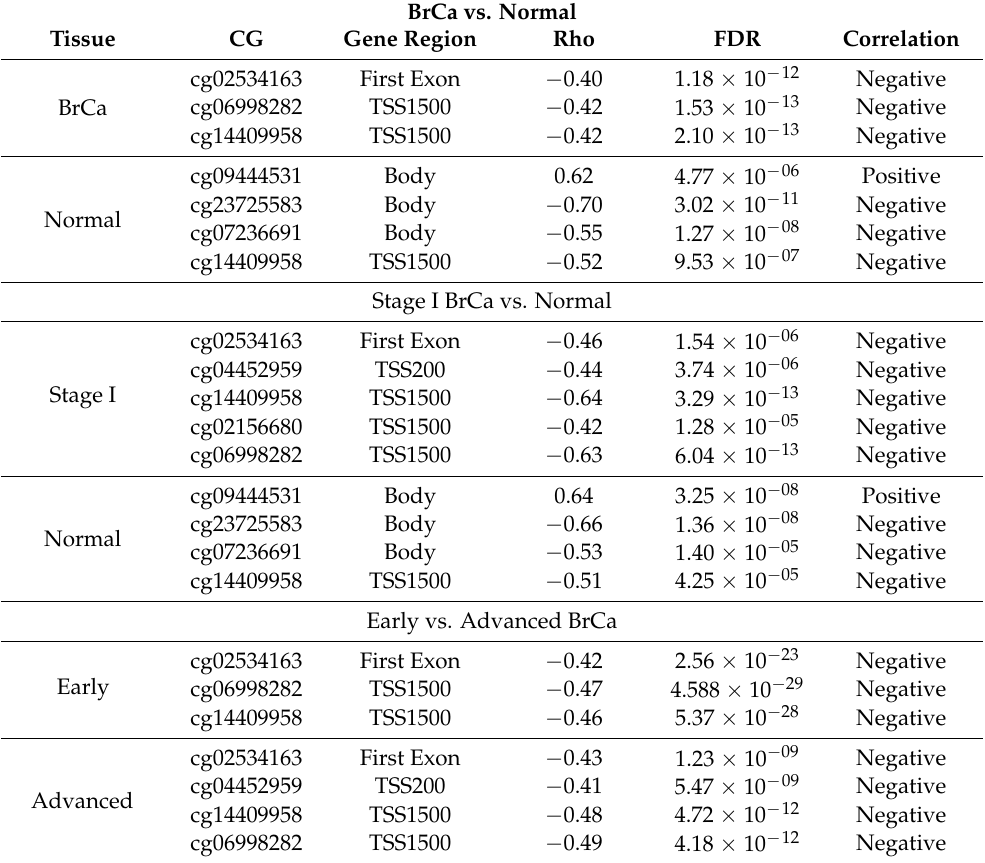
Table 3. Spearman correlation coefficient between ENPP2 CG methylation and mRNA expression for each of our clinical endpoints. CGs showing significant correlations are depicted (|rho| >= 0.40, FDR < 5 × 10 − 2